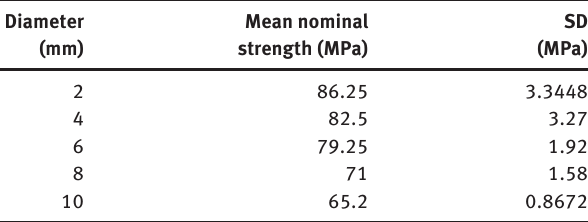
laminates open hole. 2s